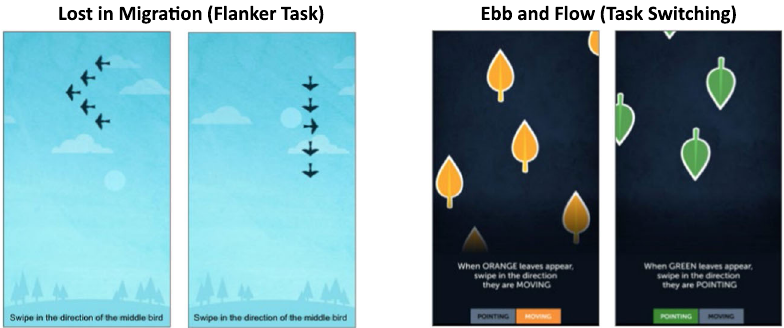
Fig. 7 Screenshots of the two cognitive games in this research. Lost in Migration ( fl anker task) and Ebb and Flow (task